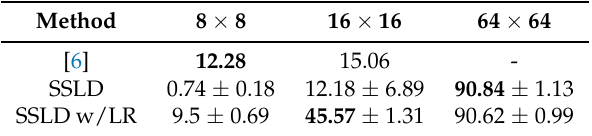
Table 2. Experiments on LFW 158 with probe images at different level of resolution. In bold we emphasize the best performance per category.